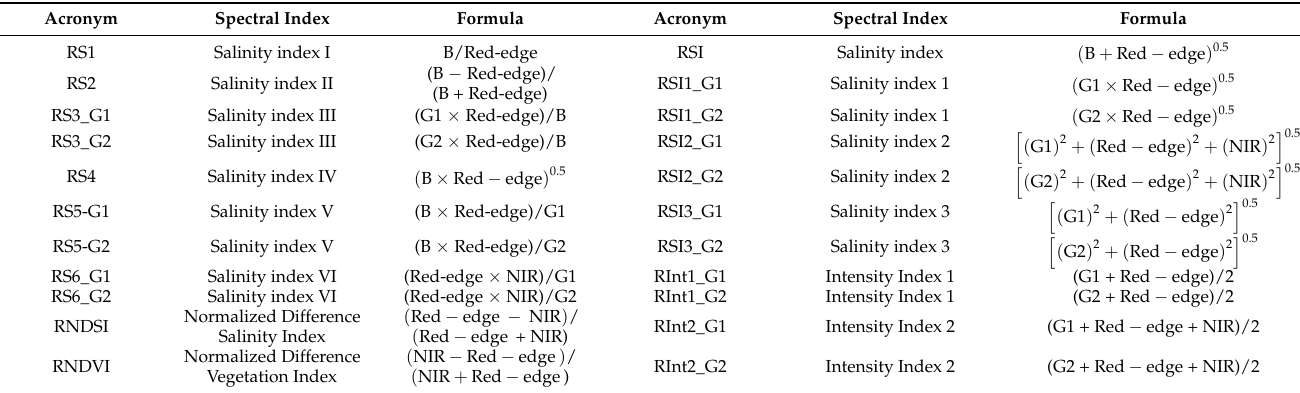
Table 3. The newly proposed red-edge spectral